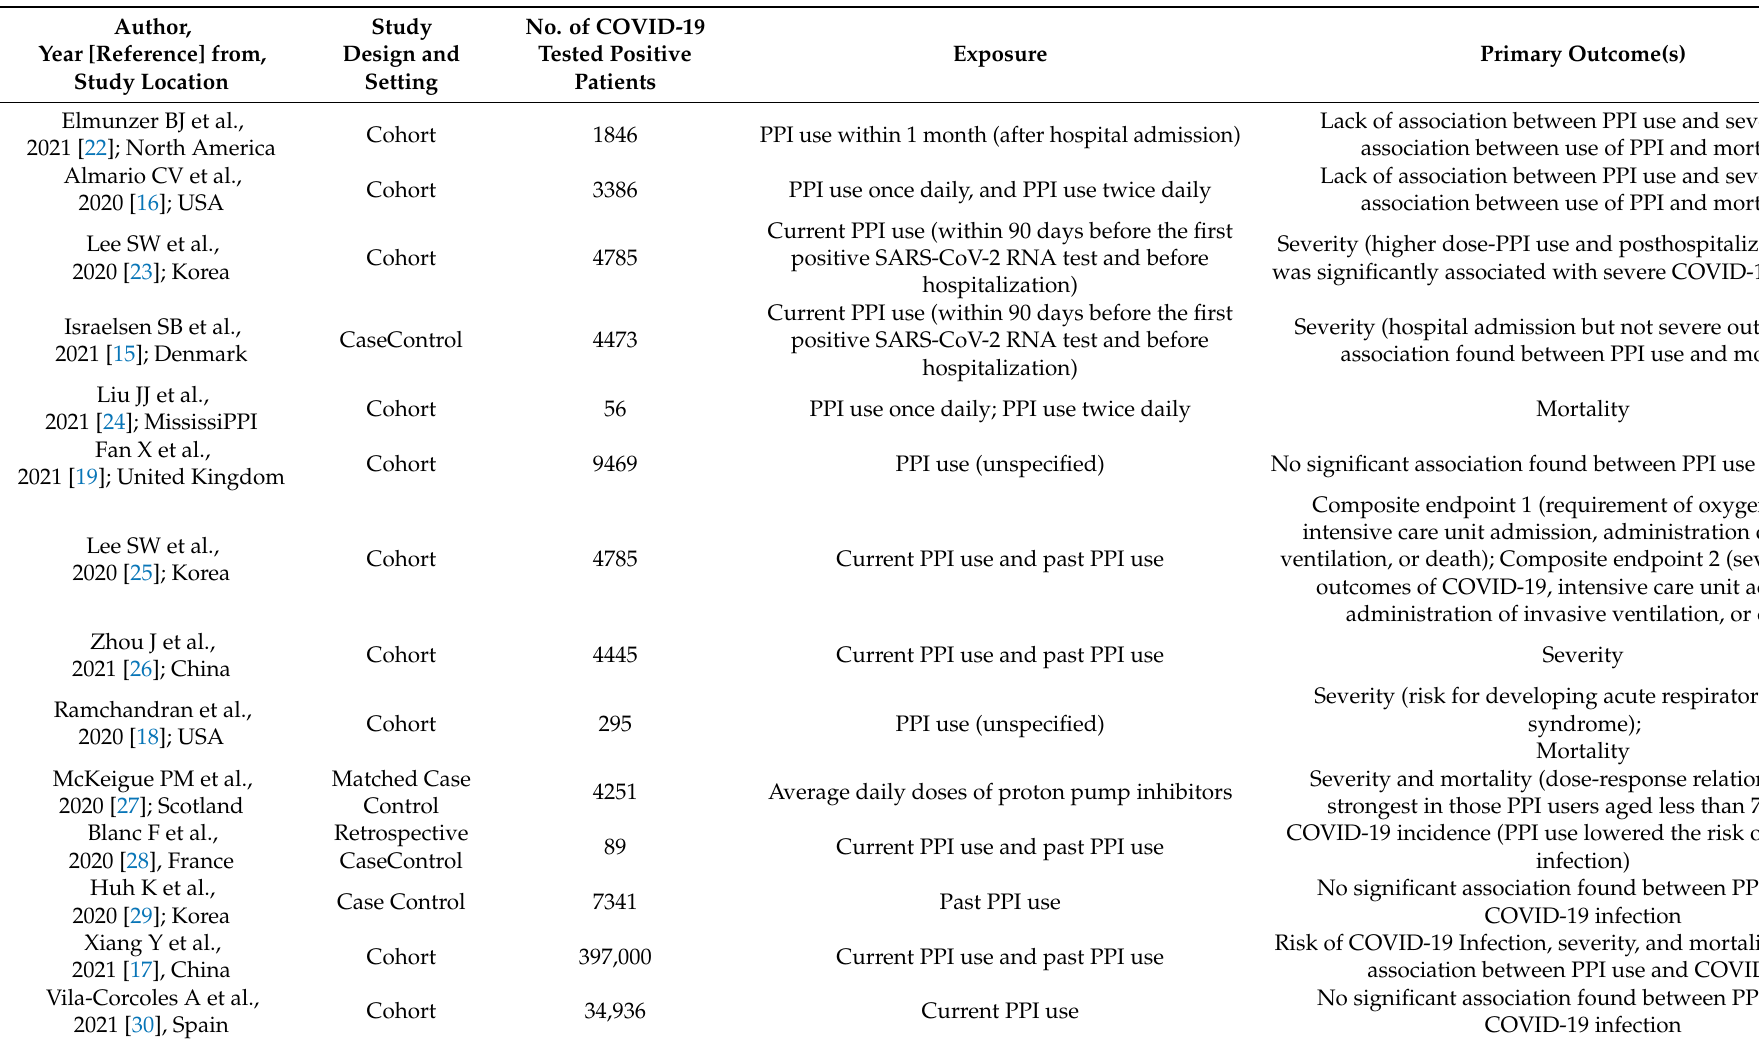
Table 1. Characteristics of included